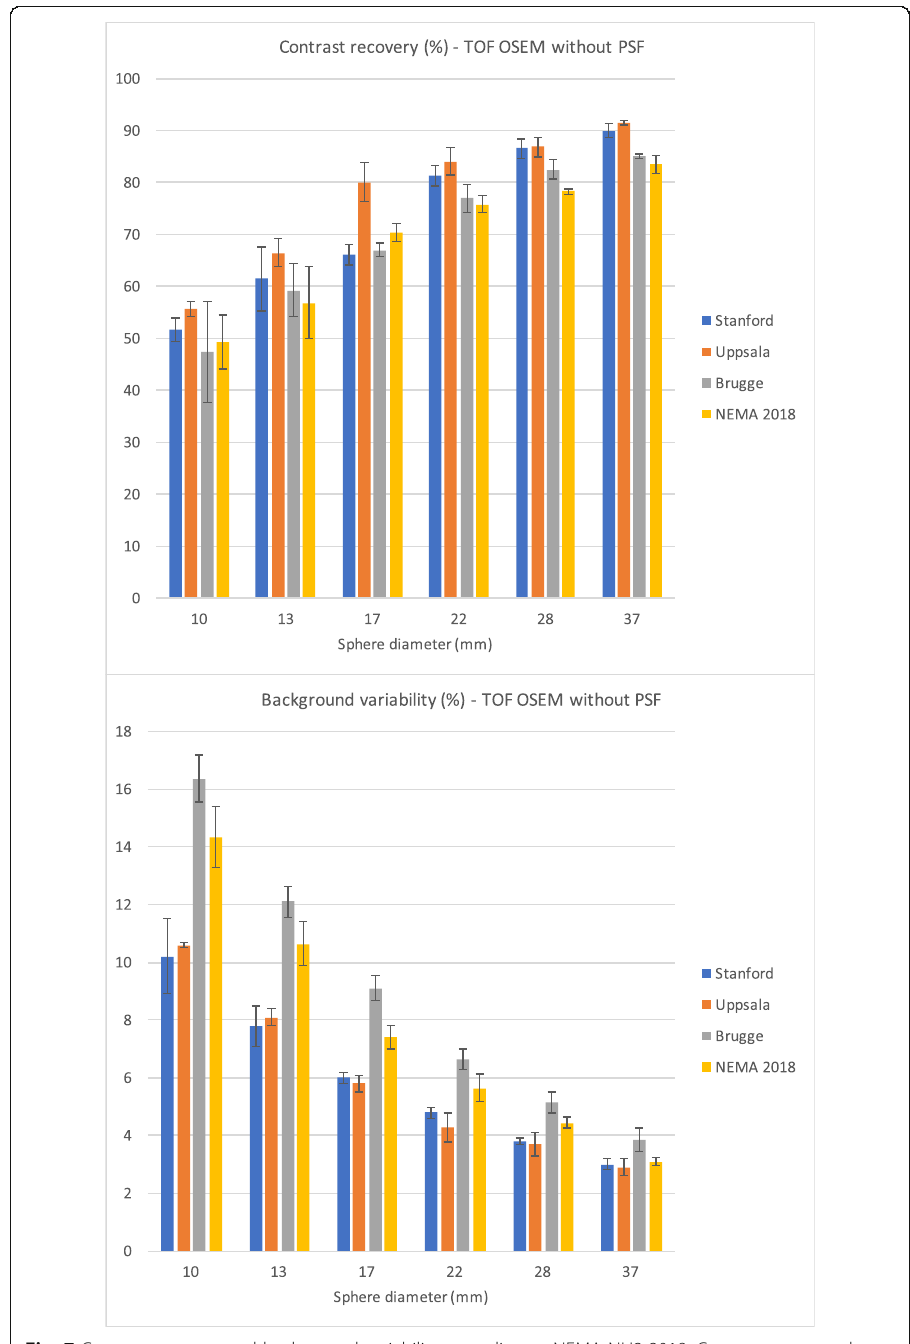
Fig. 7 Contrast recovery and background variability according to NEMA NU2-2018. Contrast recovery data are given in the upper panel and background variability in the lower panel. Data are represented for TOF OSEM reconstruction without PSF correction. The data from Fig. 5 are depicted as a